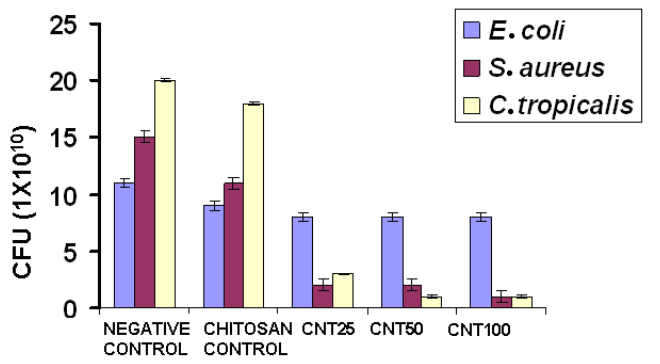
Figure 5. Antimicrobial activity of chitosan, CNT25, CNT50 and CNT100 against E. coli and S. aureus and C. tropicalis